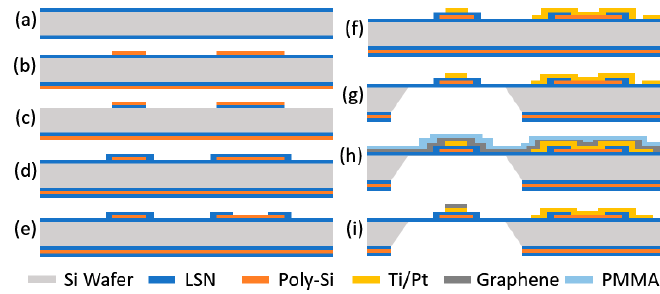
Figure 4. Fabrication process of suspended graphene gas sensor mounted on silicon based heater. Details of each process ( a ~ i ) are explained in above paragraph. Details of each process ( a ~ i ) are explained in above